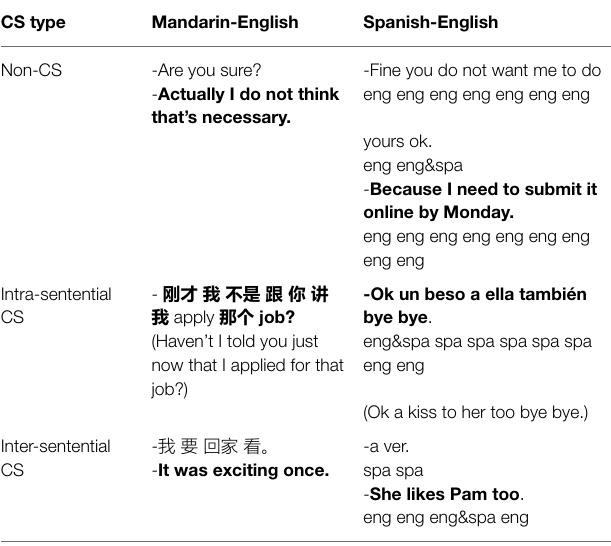
TABLE 1 | Examples of the three CS types in bilingual